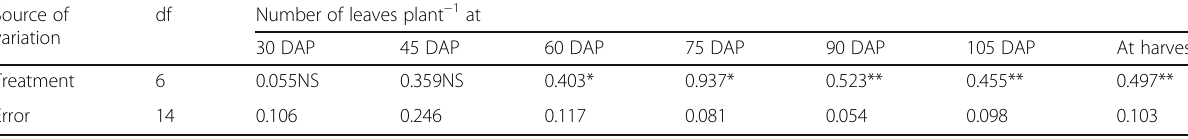
Table 7 Analysis of variance of number of leaves plant -1 of garlic at different DAP due to the different levels of K application Source of df variation